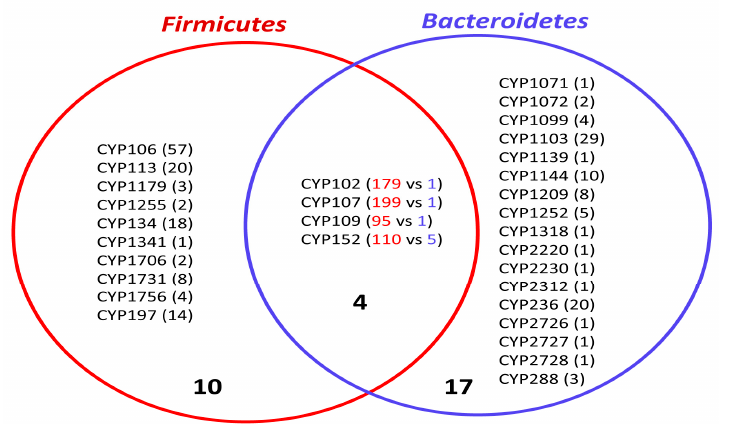
Figure 4. Comparative analysis of P450 families between Bacteroidetes - and Firmicutes -species. The number in parenthesis indicates the number of members in a P450 family. The numbers indicated with red and blue colors represent the P450 family count for Firmicutes - and Bacteroidetes -species, respectively. Numbers in bold indicate the number of P450